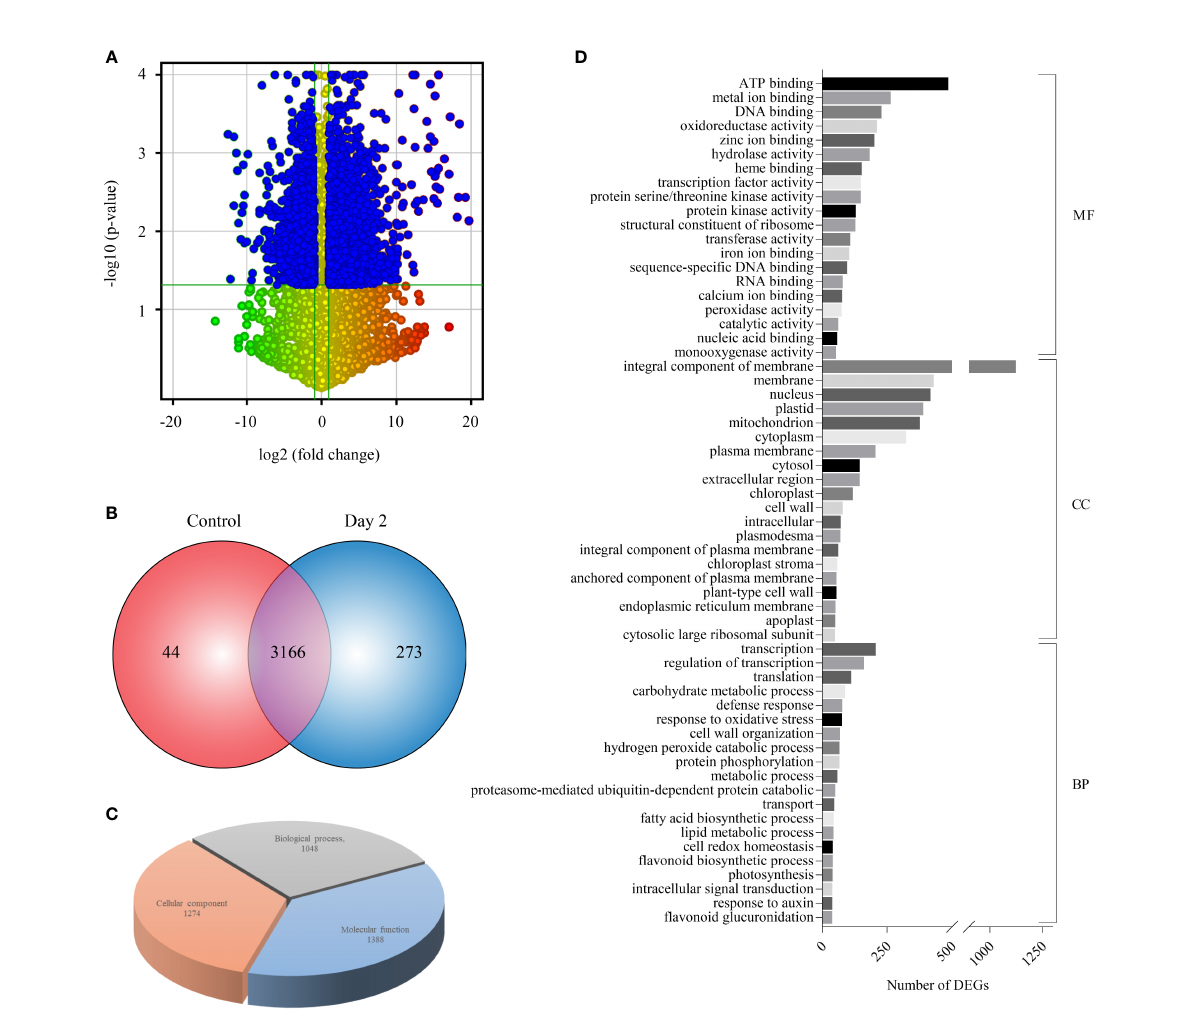
FIGURE 2 Expression pro fi ling and GO enrichment of differentially expressed genes (DEGs) during coleoptile senescence in rice. (A) Volcano scatter plot depicting the expression pattern of DEGs in RNA-Seq data of rice coleoptile senescence. Statistically signi fi cant downregulated (top left) and upregulated (top right) genes in day 2 of senescence relative to control coleoptiles are highlighted in blue color. (B) Venn diagram representing the number of DEGs speci fi c to control and senesced coleoptiles, and the ones which were expressed commonly in the two samples. (C) Gene Ontology (GO) enrichment analysis of DEGs. (D) Top twenty GO enrichment terms belonging to 3 separate sub-ontologies: molecular function (MF), cellular component (CC), and biological process (BP) and number of DEGs classi fi ed in each term are